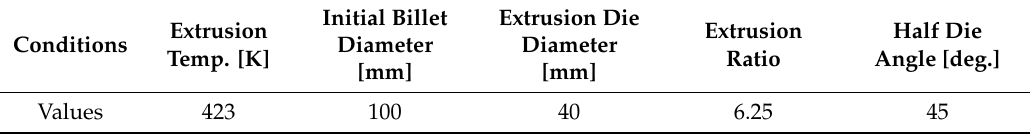
Table 1. Hydro co-extrusion process parameters.